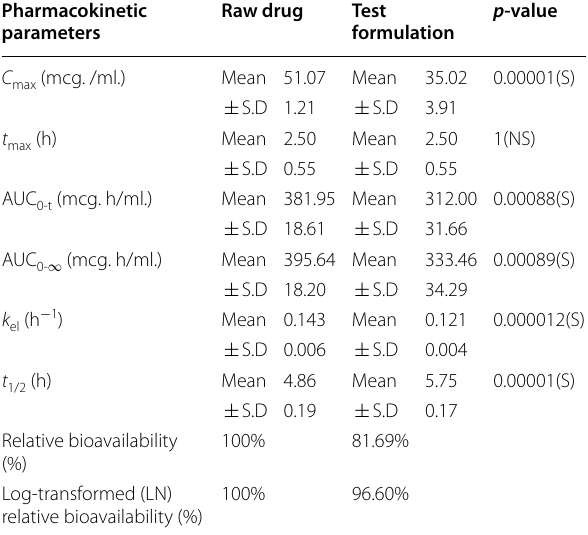
Table 3 Comparative pharmacokinetic study of satranidazole drug and test formulation